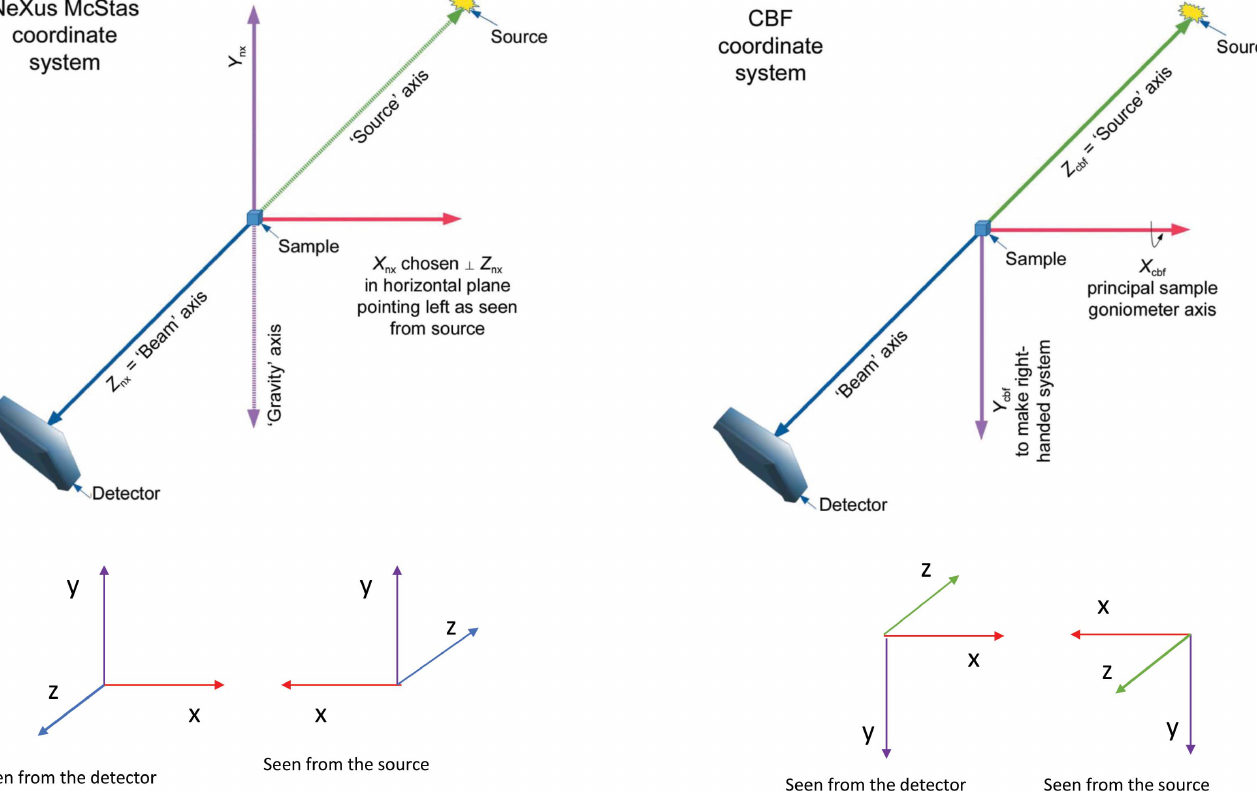
Figure 1 The Nexus McStas axis system is different from the CBF laboratory system. Seen from the source in McStas, Z points away from the source and the X axis points to the left, while in CBF Z points back into the source and X is along the principal goniometer axis, i.e. points into the goniometer block. A vector defined in McStas is brought by a 180 (cid:3) rotation around Nexus_X to the CBF system. Note that if the goniometer is at the opposite side, the transformation is around Nexus_Y (image courtesy of the Gold Standard paper, Bernstein et al. ,